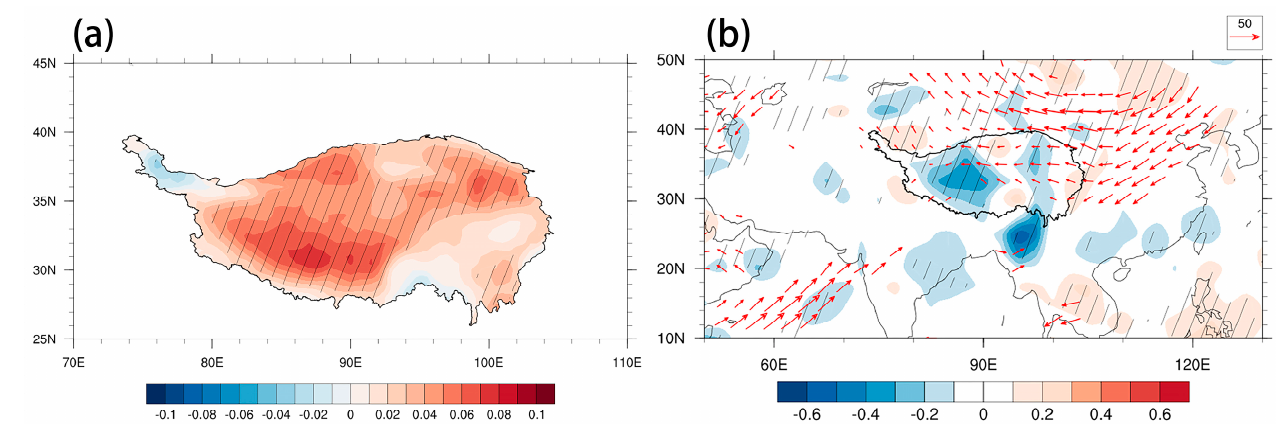
Figure 5. Spatial distribution of difference in total cloud cover ( a ), water vapor flux exceeding the 95% confidence level (vector, kg m − 1 s − 1 ), and divergence (shading, 10 − 4 kg m − 2 s − 1 ) ( b ) between 1997–2018 and 1981–1995. Grid points with statistically significant anomalies passing the 95% confidence level are denoted by oblique lines.